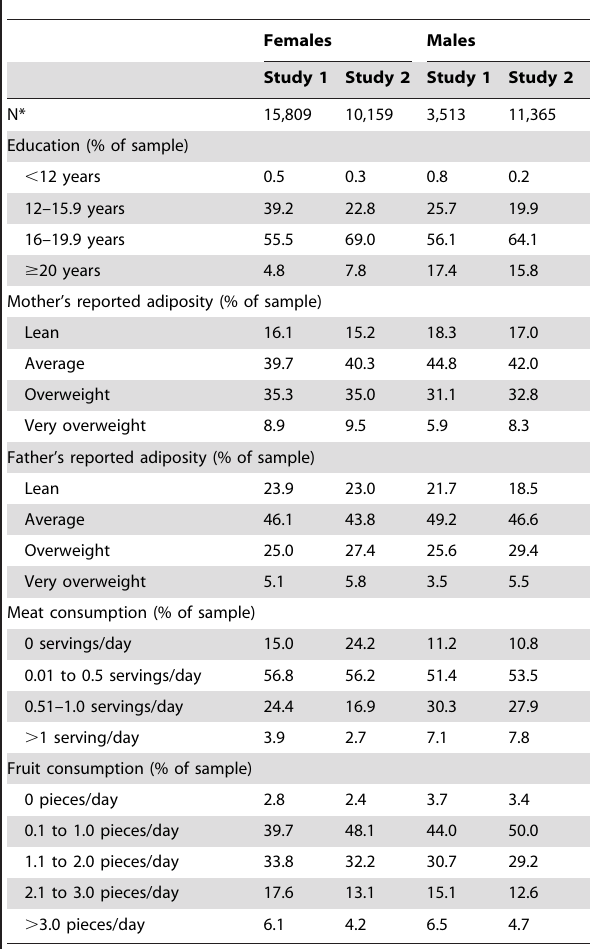
Table 1. Distribution of obesity risk factors in two independent